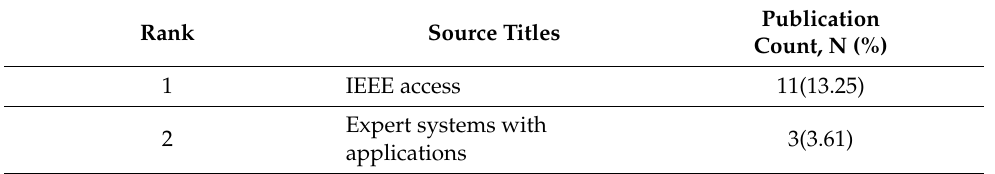
Table 11. Top ten publication sources on Web of Science (N =